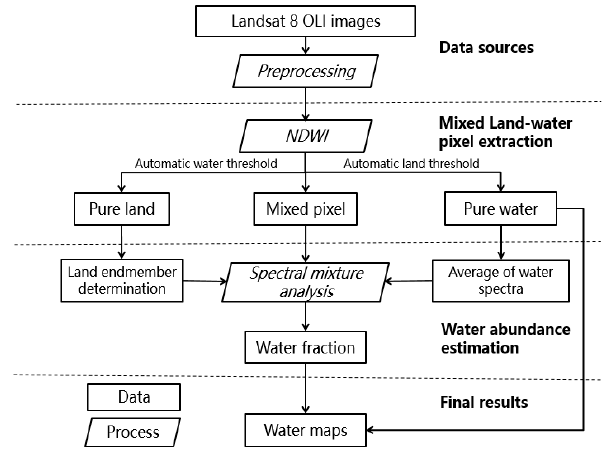
Figure 2. Flowchart of the proposed ASWM method.